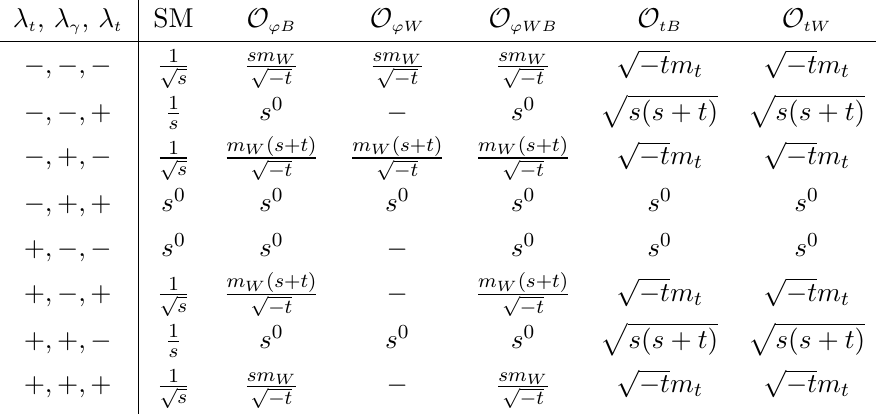
t v ) for t(cid:13) th scattering. (cid:24) (cid:0) (cid:29) ! ’ indicate any combination of ; . See (cid:3) (cid:6) (cid:7)